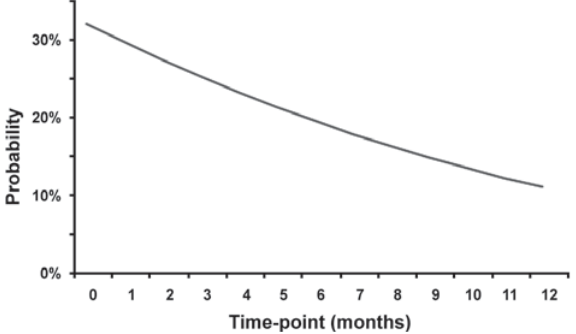
Figure 1- Relationship between breastfeeding duration and the probability of having anterior open bite (derived from the logistic regression model shown in Table 3) Table 5- (cid:2)(cid:3)(cid:4)(cid:5)(cid:6)(cid:7)(cid:8)(cid:2)(cid:9)(cid:10)(cid:11)(cid:4)(cid:12)(cid:13)(cid:4)(cid:14)(cid:2)(cid:7)(cid:15)(cid:11)(cid:7)(cid:15)(cid:12)(cid:12)(cid:4)(cid:10)(cid:5)(cid:2)(cid:16)(cid:10)(cid:7)(cid:2)(cid:6)(cid:5)(cid:6)(cid:9)(cid:8)(cid:17)(cid:4)(cid:5)(cid:11)(cid:2)(cid:13)(cid:18)(cid:15)(cid:2)(cid:4)(cid:5)(cid:19)(cid:20)(cid:15)(cid:5)(cid:14)(cid:15)(cid:2)(cid:10)(cid:16)(cid:2)(cid:21)(cid:7)(cid:15)(cid:6)(cid:12)(cid:13)(cid:16)(cid:15)(cid:15)(cid:22)(cid:4)(cid:5)(cid:11)(cid:2)(cid:22)(cid:20)(cid:7)(cid:6)(cid:13)(cid:4)(cid:10)(cid:5)(cid:2)(cid:10)(cid:5)(cid:2)(cid:13)(cid:18)(cid:15)(cid:2)(cid:23)(cid:7)(cid:15)(cid:24)(cid:6)(cid:9)(cid:15)(cid:5)(cid:14)(cid:15)(cid:2)(cid:10)(cid:16)(cid:2)(cid:5)(cid:10)(cid:5)(cid:25)(cid:5)(cid:20)(cid:13)(cid:7)(cid:4)(cid:13)(cid:4)(cid:24)(cid:15)(cid:2) sucking habits in the total sample (n=1,377)